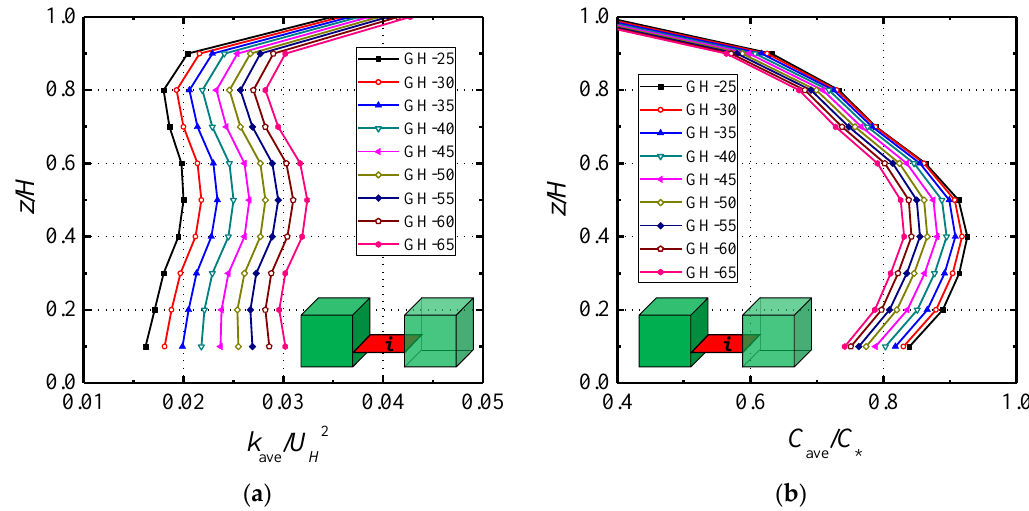
Figure 12. Plane-averaged scalar fields in the TSC: ( a ) plane-averaged turbulent kinetic energy; ( b ) plane-averaged pollutant concentration.